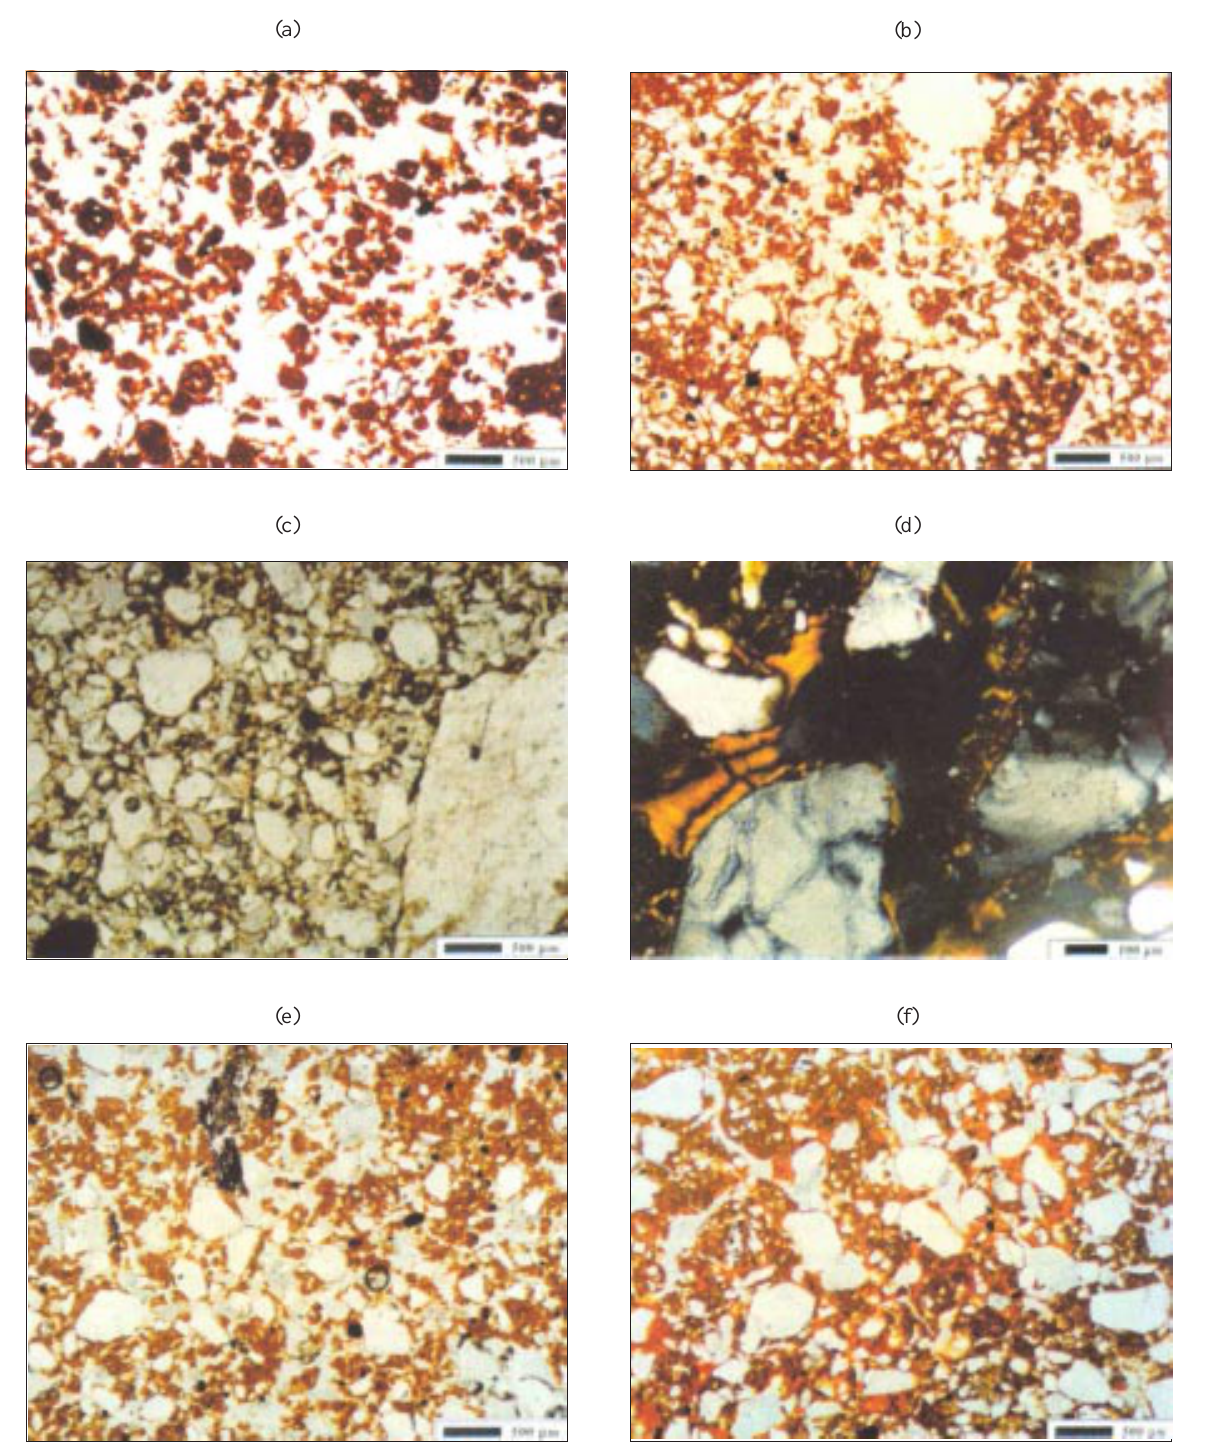
Figura 4. Fotomicrografias de horizontes dos pedons estudados. (a) P1, horizonte Bw (130-137 cm): trama grânica e plasma isótico. (b) P2, horizonte AB: trama porfírica e grãos com grau de seleção inferior ao P1. (c) P3, horizonte A: trama gefúrica e grãos com grau de seleção muito baixo. (d) P3 horizonte Bt (110-118 cm): ferriargilãs de iluviação. (e) P5, horizonte Bw (95-103 cm): trama granóidica, plasma isótico e ausência de minerais primários facilmente intemperizáveis. (f) P5, horizonte Bt (52-60 cm): trama porfírica formada por coalescência de microagregados interpretada como advinda de argiluviação (Fotomicrografias a,b,c,e,f sob luz polarizada em um plano. Fotomicrografia d sob nicóis